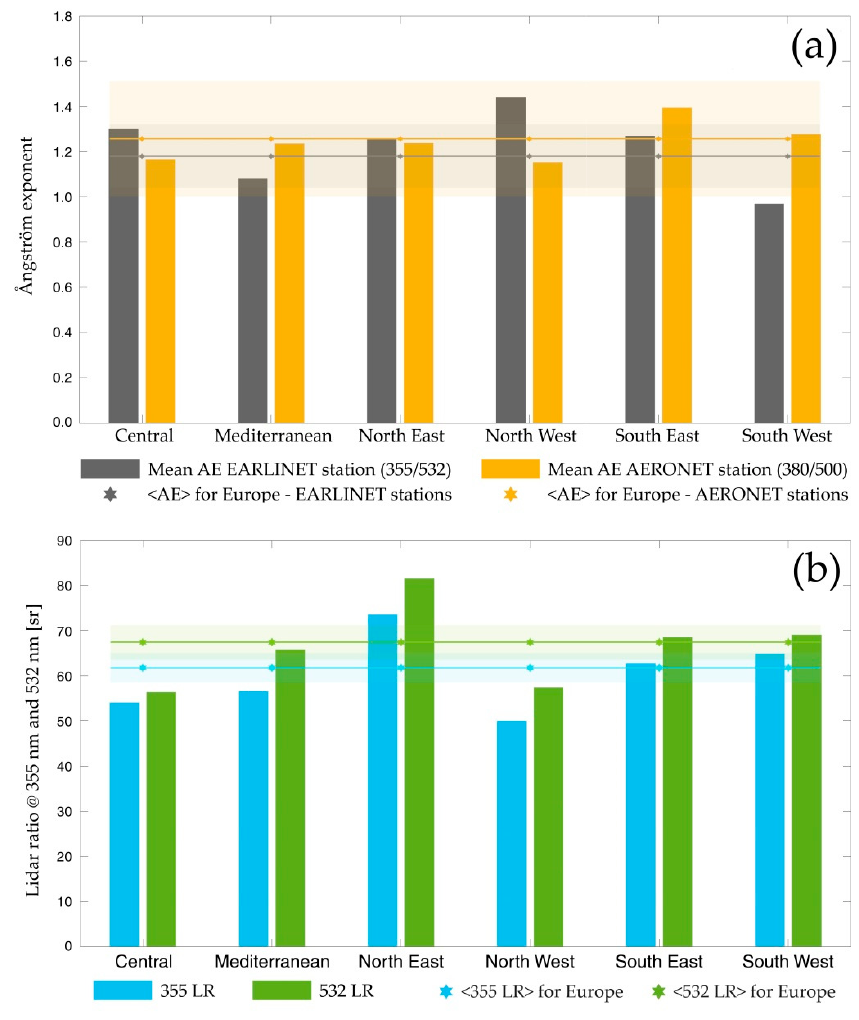
Figure 2. Optical properties of aerosols as retrieved from EARLINET lidar measurements and AERONET photometer measurements between 2008 and 2018: ( a ) mean values of Angstrom exponents from lidar (355/532 nm, dark gray bar) and from photometers (380/500 nm, orange bar) for each cluster; ( b ) mean values of lidar ratios from lidar at 355 nm (blue bar) and 532 nm (green bar) for each cluster. The mean European values (dark gray and orange lines for the Angstrom exponents and blue and green lines for the lidar ratios) and the standard deviations (shaded) are indicated.